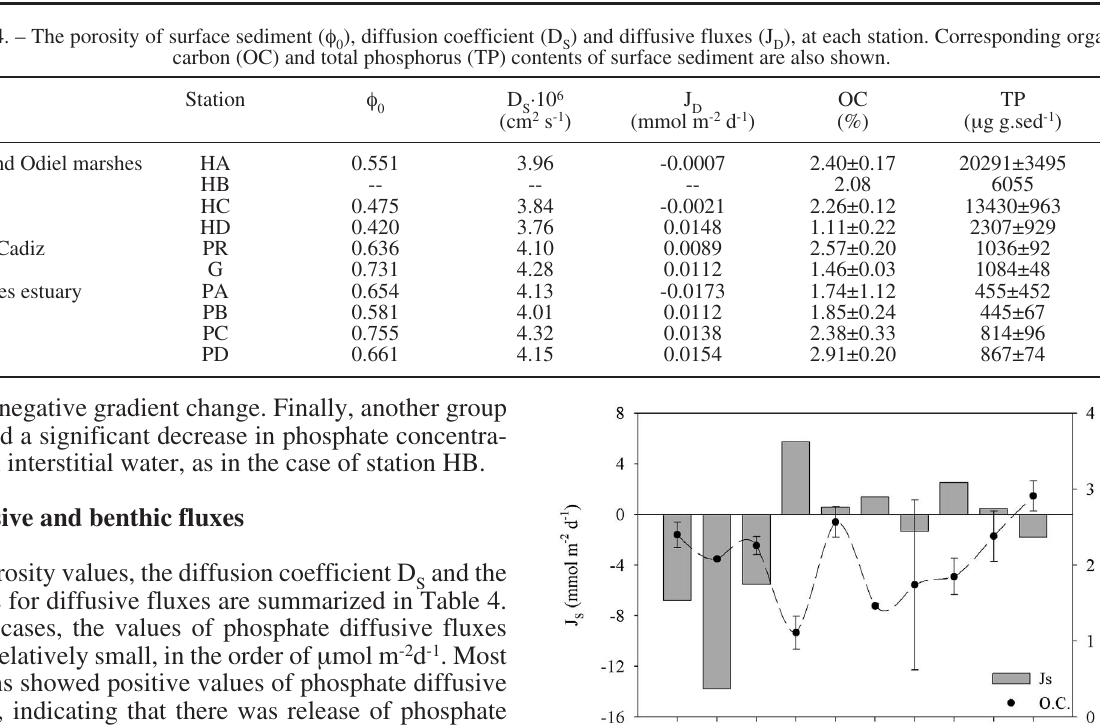
Table 4. – The porosity of surface sediment ( f